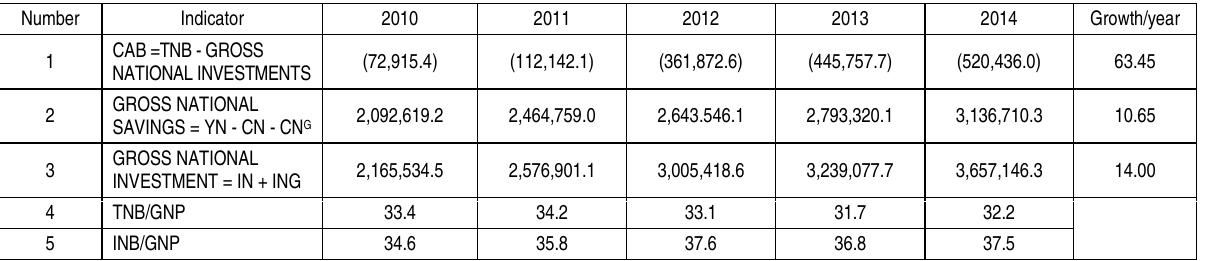
Table 2. The gross national savings, gross national investments and Indonesian current account balance, 2010-2014 (billion